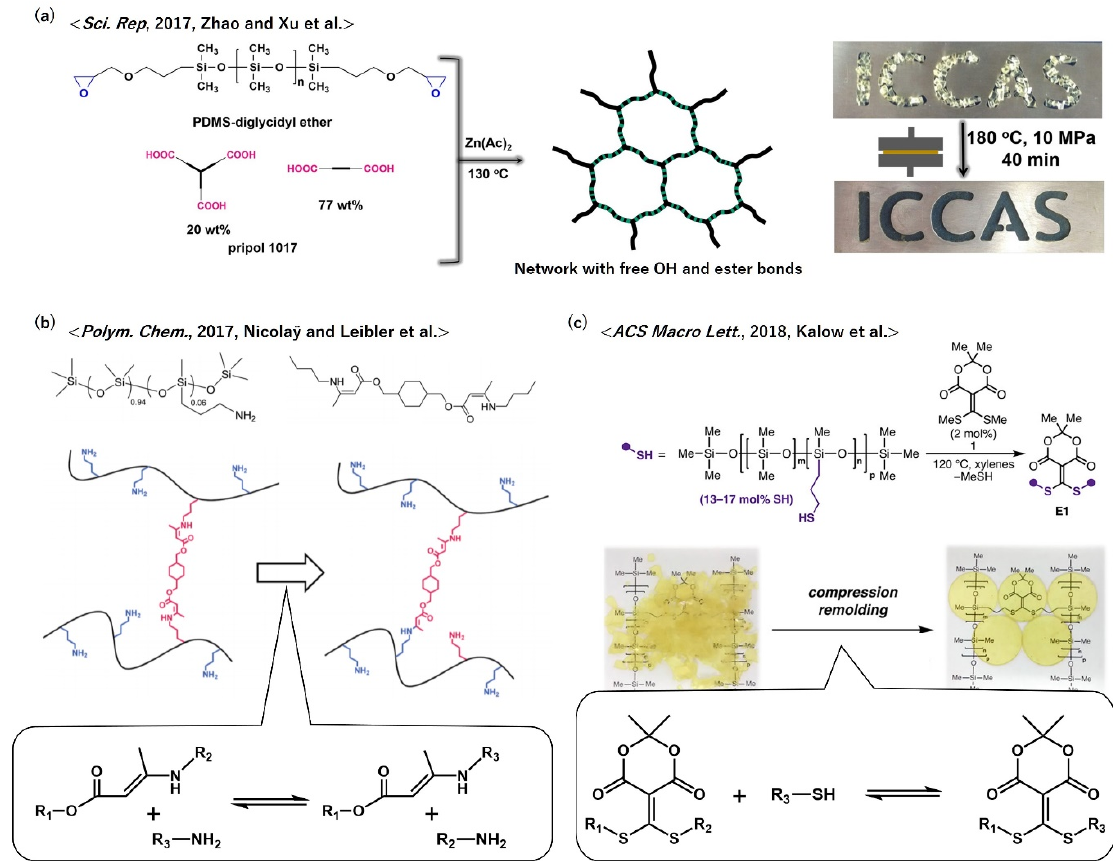
Figure 12. Molecular designs of vitrimer polydimethylsiloxanes according to ( a ) ref. [55], ( b ) ref. [56] ( b ), and ( c ) ref. [58]. In ( b ) and ( c ), the bond exchange mechanism of vinylogous urethane exchange and the trans-thioetherification of Meldrum’s acids are shown, respectively. ( a ) Adapted from ref.